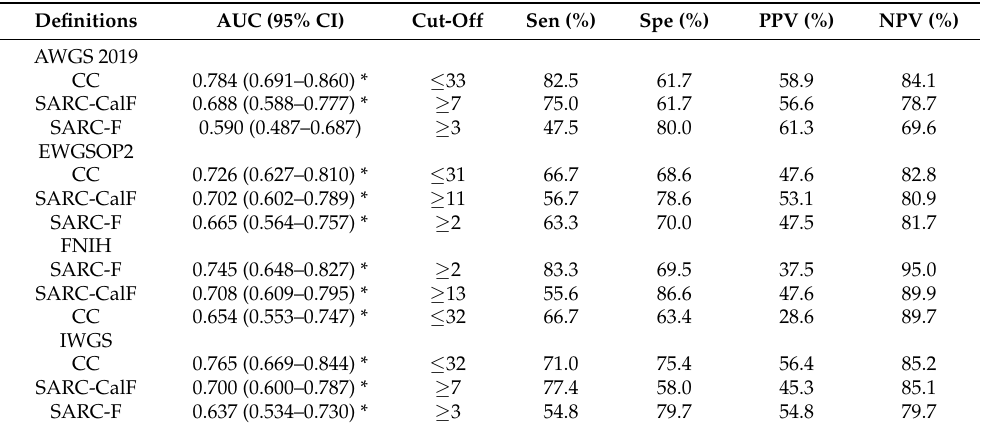
Table 6. The diagnostic performance of SARC-F, SARC-CalF, and CC on sarcopenia based on four operational definitions in female patients undergoing